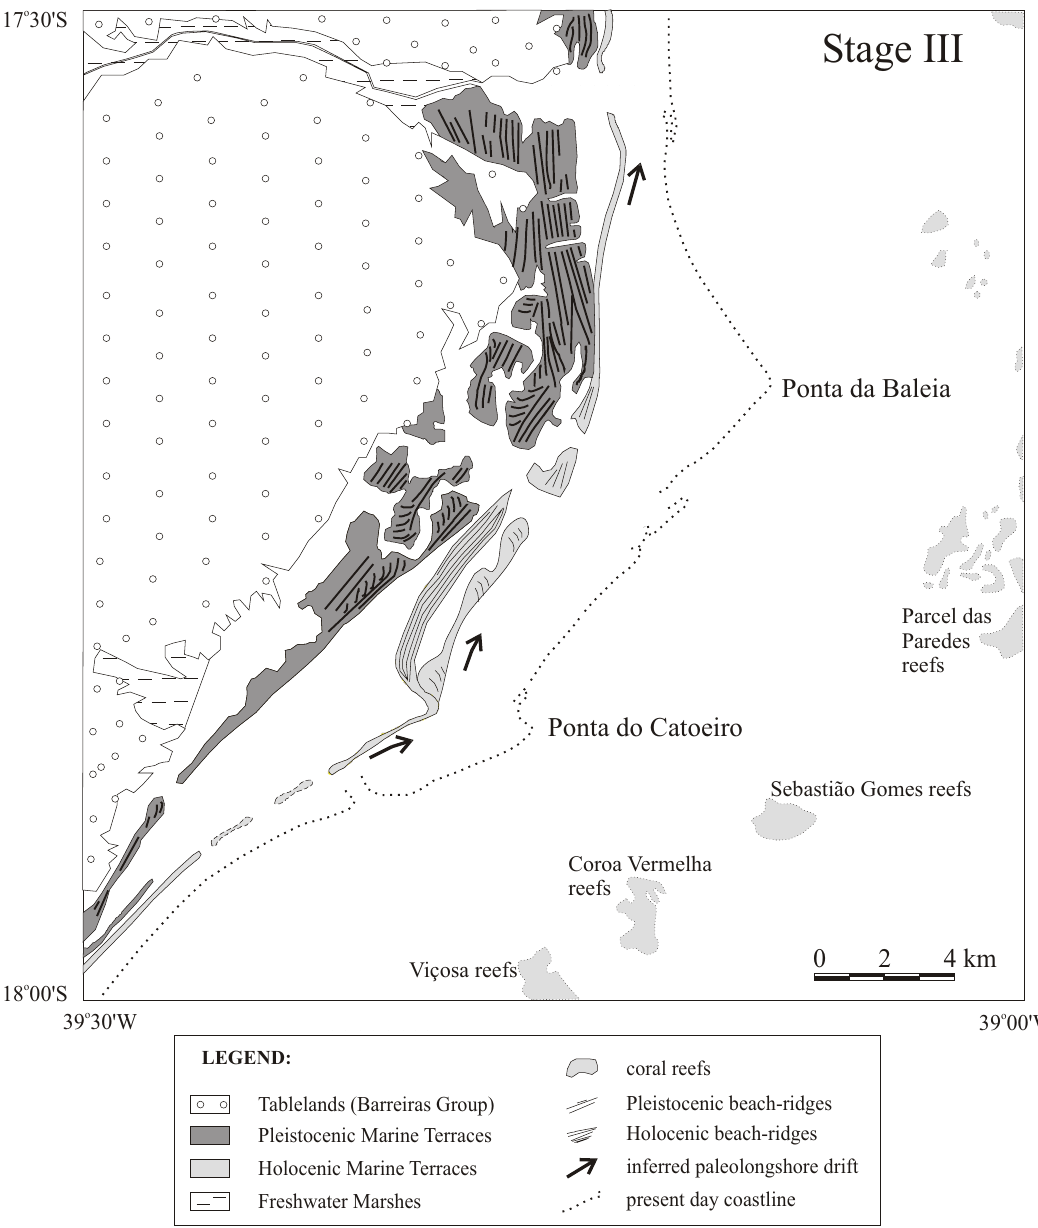
Fig. 11 – Quaternary evolution of the Caravelas strandplain: Stage III – Coastline progradation in the embayment situated between the paleo-Ponta da Baleia and the paleo-Ponta do Catoeiro (5,600 cal. years B.P. or 5,200 years C 14 B.P.).